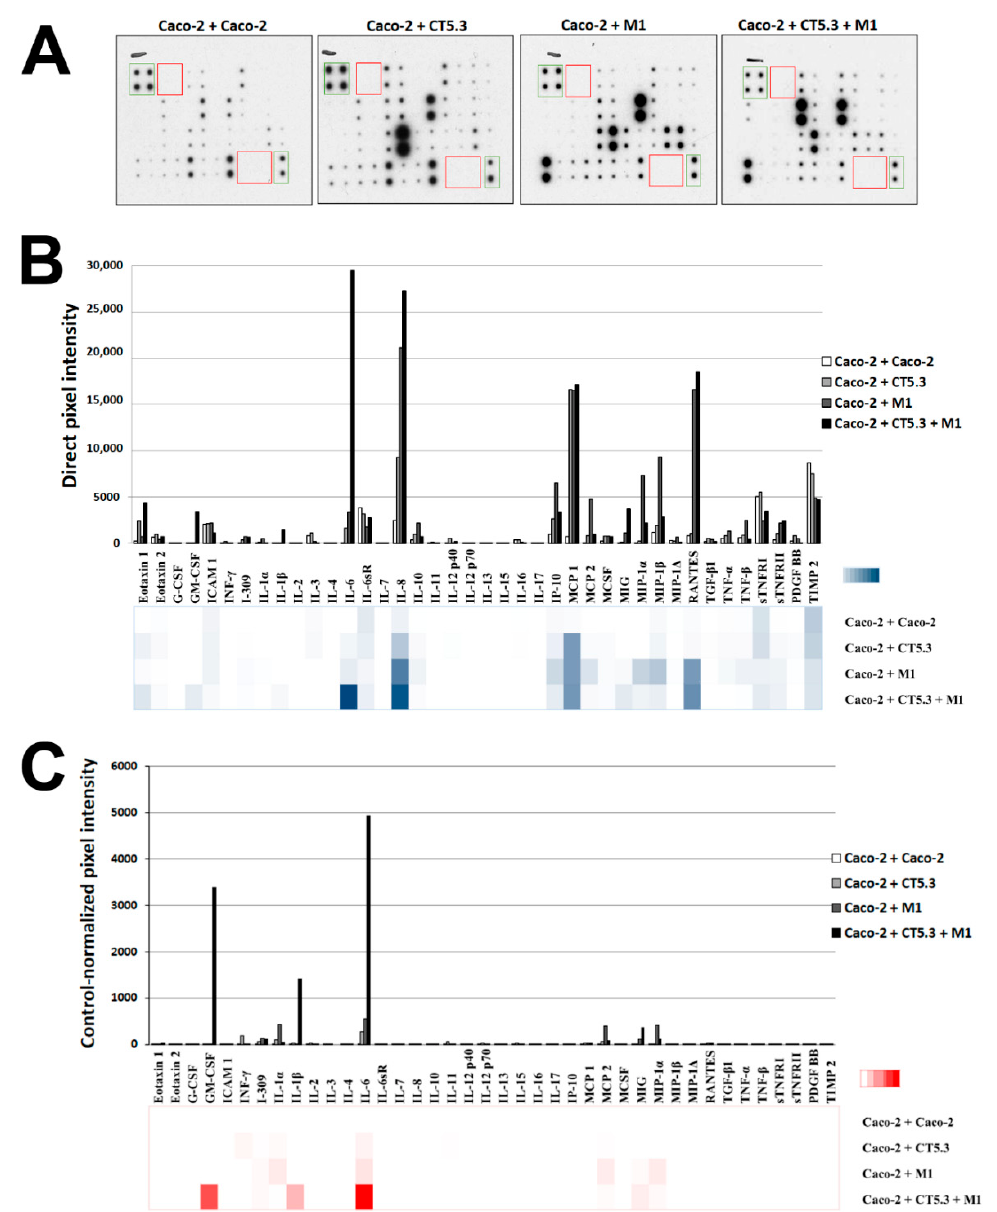
Figure 4. Identification of cytokines from the co-culture medium. Following the co-culture of polarized Caco-2 cells with the indicated cell types, the corresponding media were incubated with antibody arrays and their cytokine composition detected by a WB-like procedure. ( A ) Shown are the observed signal intensities, with positive and negative control spots marked by green or red boxes, respectively. ( B ) Graphic display of the direct pixel intensities observed for each cytokine under the four conditions. ( C ) Graphic display of the pixel intensities after normalization to the background values obtained in the control co-culture with Caco-2